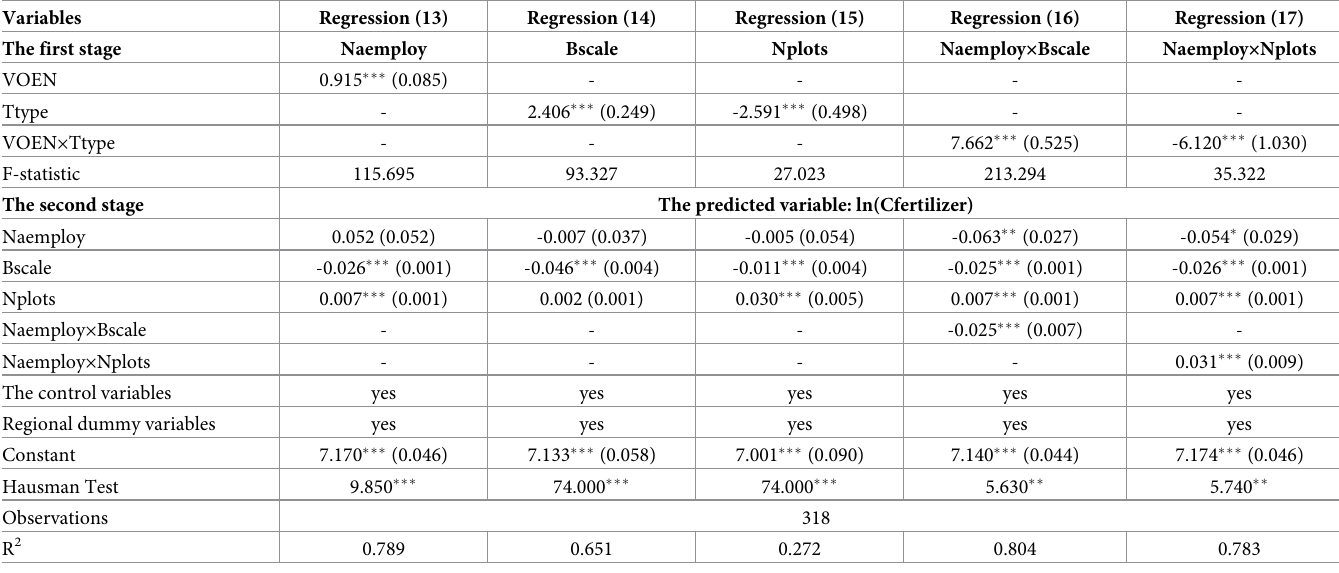
Table 6. Estimated results of instrumental